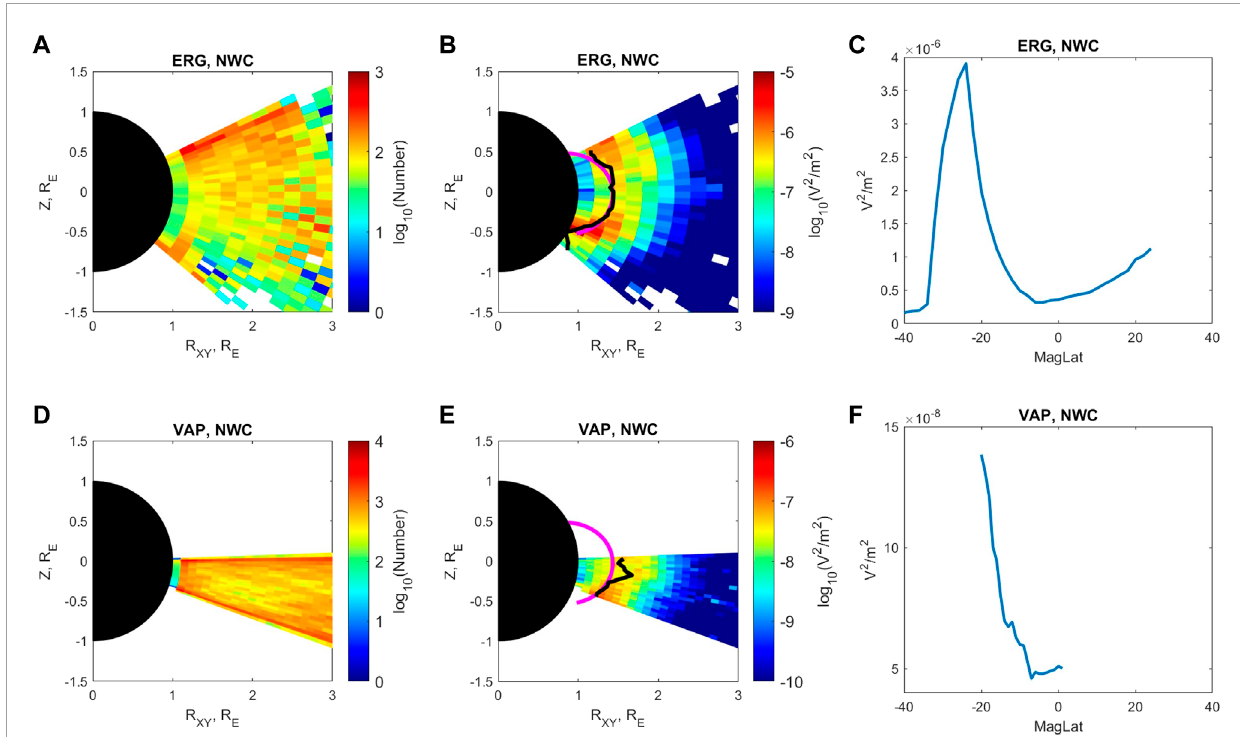
FIGURE 2 The meridional distribution of data number (A) , NWC wave power (B) , and the variation of peak wave power A 0 over magnetic latitude (C) from ERG/Arase observations. Panels (D–F) are observations from Van Allen Probes. R xy is the distance from the Earth’s diple axis ( Z -axis). The black solid lines in (B, E) represent the trajectory of peak wave power location r 0 for the ERG/Arase and Van Allen Probes observations, respectively. The magenta solid line is the IGRF magnetic field line starting from the maximum NWC transmitter wave power location observed by DEMETER.